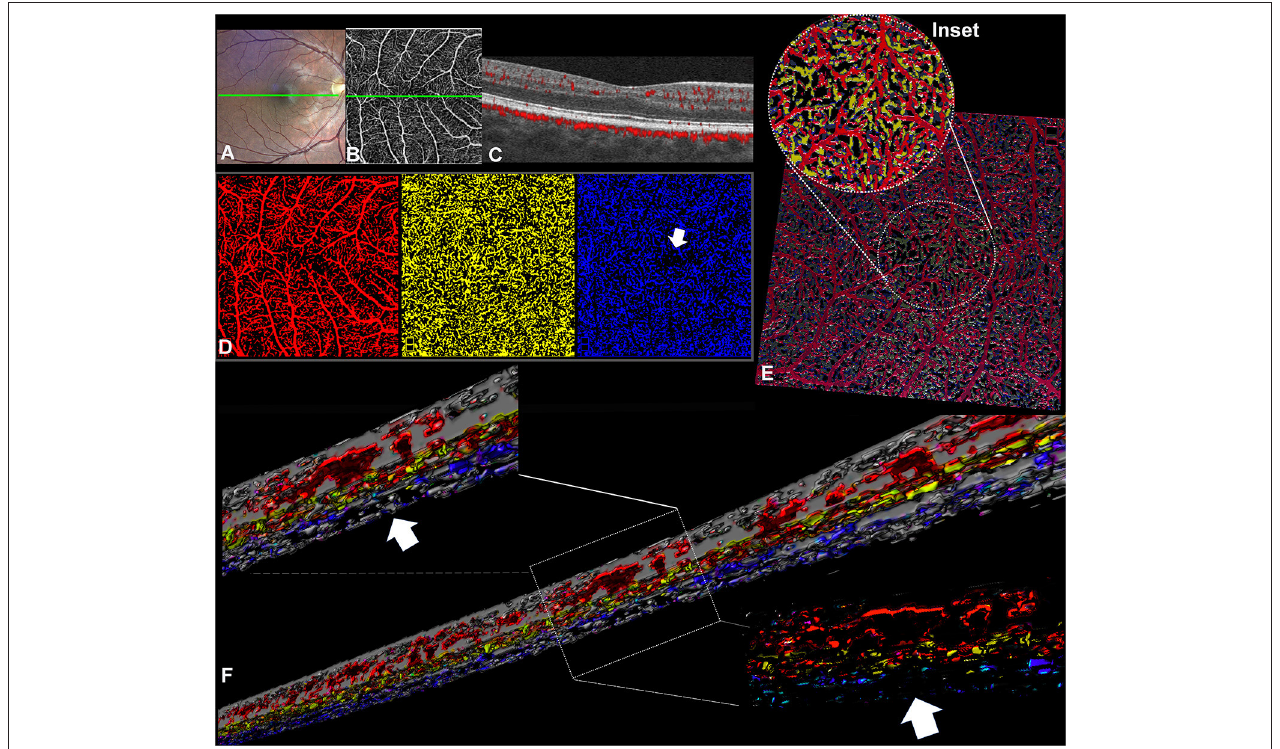
FIGURE 1 | Optical coherence tomography angiography (OCTA) processing in a case of idiopathic fovea plana (Case 1). (A) TrueColor Confocal Fundus Imaging (Compass, Centervue, Padova, Italy). (B) En face OCTA (RTVue XR Avanti, Optovue, Inc., Fremont, CA) depicting the superficial vascular complex (SVC) with the retinal capillary network crossing the macular area. (C) The OCTA b scan obtained in correspondence of the green line confirms the fovea plana appearance. (D) En face OCTA slabs binarized and false-colored, the SVC (red) and ICP (yellow) show retinal capillaries occupying the macular region without a discernible avascular zone, while the DCP (blue) demonstrates a discrete central avascular area (white arrow). (E) Volume rendering obtained from the binarized and false-colored en face slabs allows better visualization of the spatial relation between SVC and ICP in the central macular region where the DCP is not visible. (F) Three-dimensional reconstruction of the OCTA b scans shows the absence of the vascular net at the level of the DCP but several interconnections between the SVC and